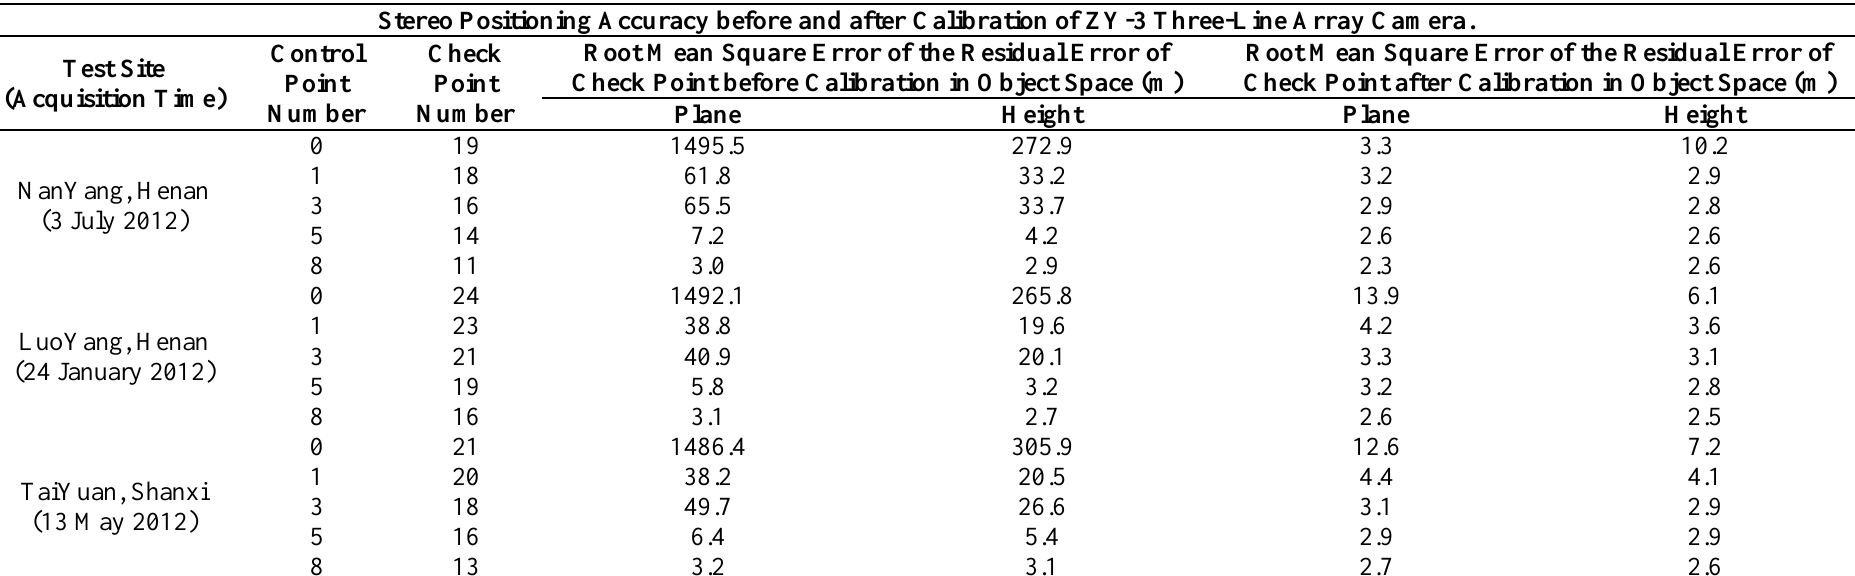
Table 6. Stereo geometric positioning accuracy before and after calibration of ZY-3 three-line array